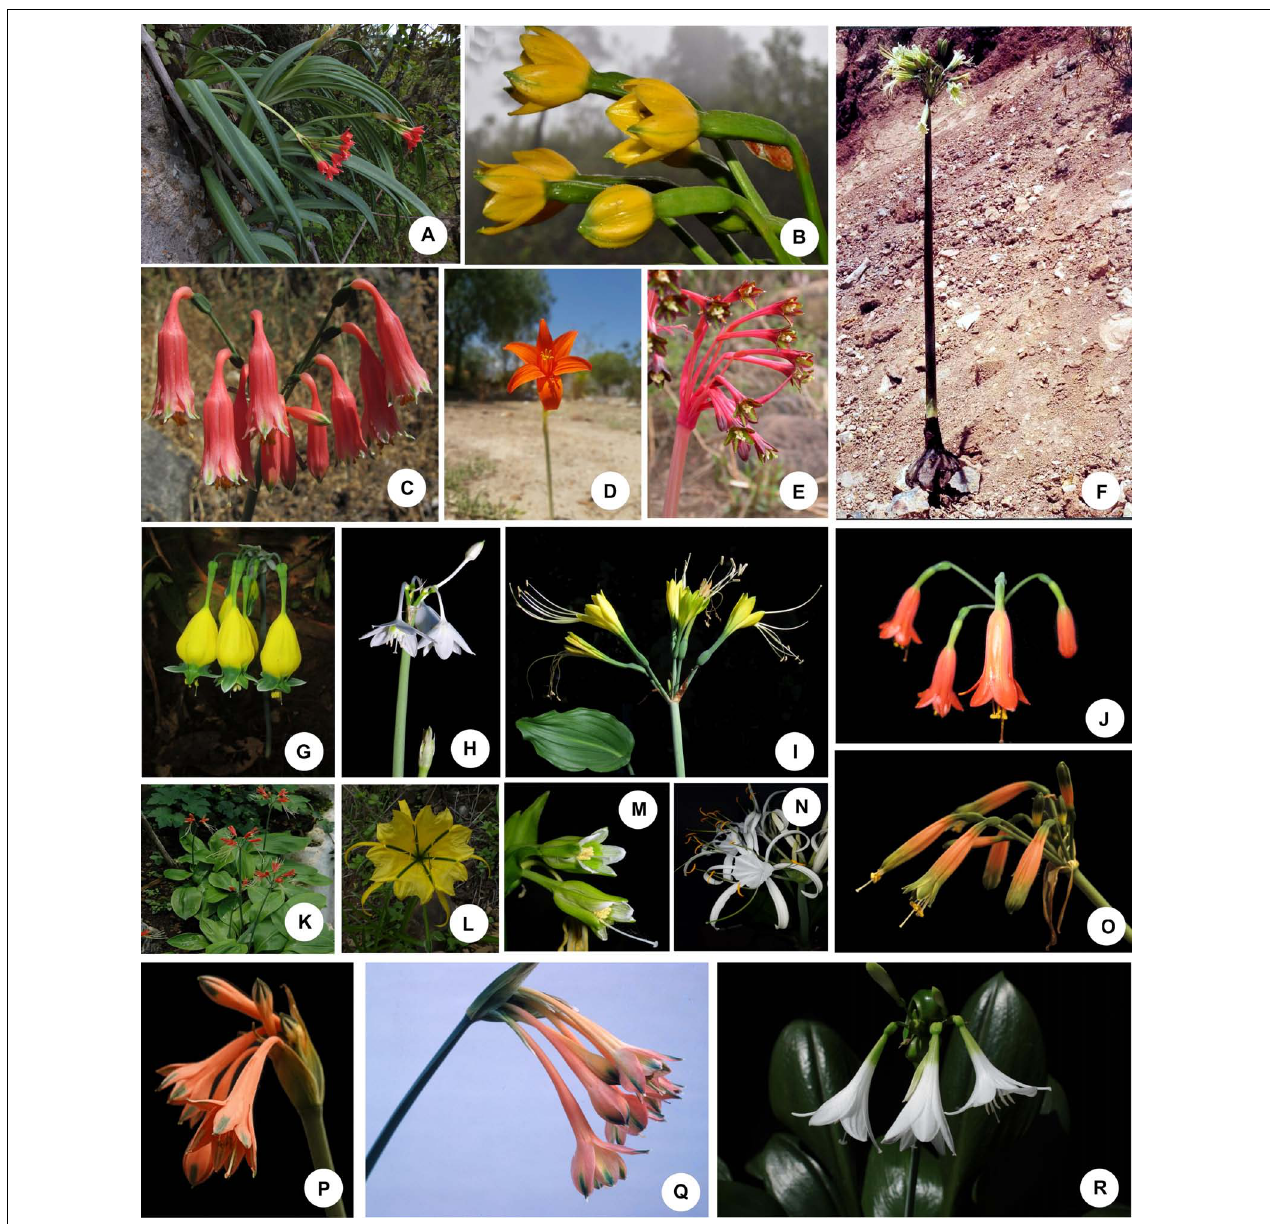
FIGURE 1 | Representative species of the Andean tetraploid clade of the American Amaryllidaceae. (A–C,P,Q) Tribe Clinantheae. (D,E) Tribe Eustephieae. (F–K,O,R) Tribe Eucharideae. (L–N) Tribe Hymenocallideae. (A) Paramongaia milagroantha (Leiva & Meerow) Meerow. (B) Pamianthe ecollis Silverst., Meerow & Sánchez-Taborda. (C) . Clinanthus campodensis (Ravenna) Meerow. (D) Pyrolirion tubiflorum L’Hér.) M.Roem. (E) Hieronymiella latifolia (R.E.Fr.) Di Fulvio & Hunz. (F) Rauhia albescens Meerow & Sagást. (G) Urceolina pendula Herb. (H) Eucharis cyaneosperma Meerow. (I) Eucrosia dodsonii Meerow & Dehgan. (J) Stenomesson ecuadorense Meerow, Oleas & L.Jost. (K) Eucrosia bicolor Ker Gawl. (L) Leptochiton helianthus (Ravenna) Gereau & Meerow. (M) Ismene parviflora Meerow & A. Cano. (N) Hymenocallis speciosa (L.f. ex Salisb.) Salisb. (O) Phaedranassa ventricosa Baker. (P) Clinanthus incarnatus (Kunth) Meerow. (Q) Clinanthus variegatus (Ruiz & Pav.) Meerow. (R) Caliphruria subedentata Baker. Photo credits: (A,C,L) Segundo Leiva. (B) Jhon A. Sánchez-Taborda. (D,I–K,N–R) Alan Meerow. (E) John Wood. (F) Abundio Sagástegui. (G,H) Günter Gerlach. (M) Asuncíon Cano. Photos used by